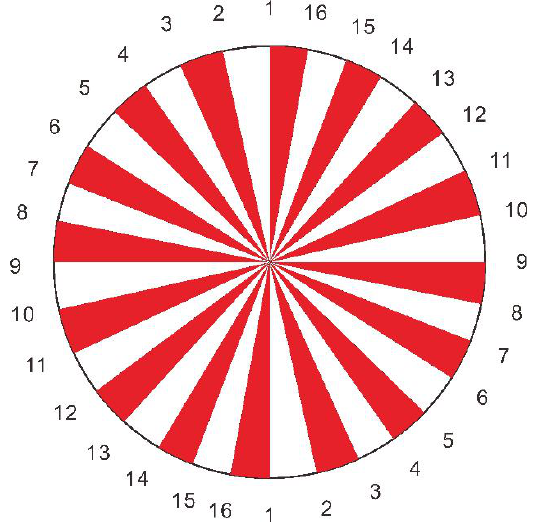
Figure 8. Lineament interpretation results.